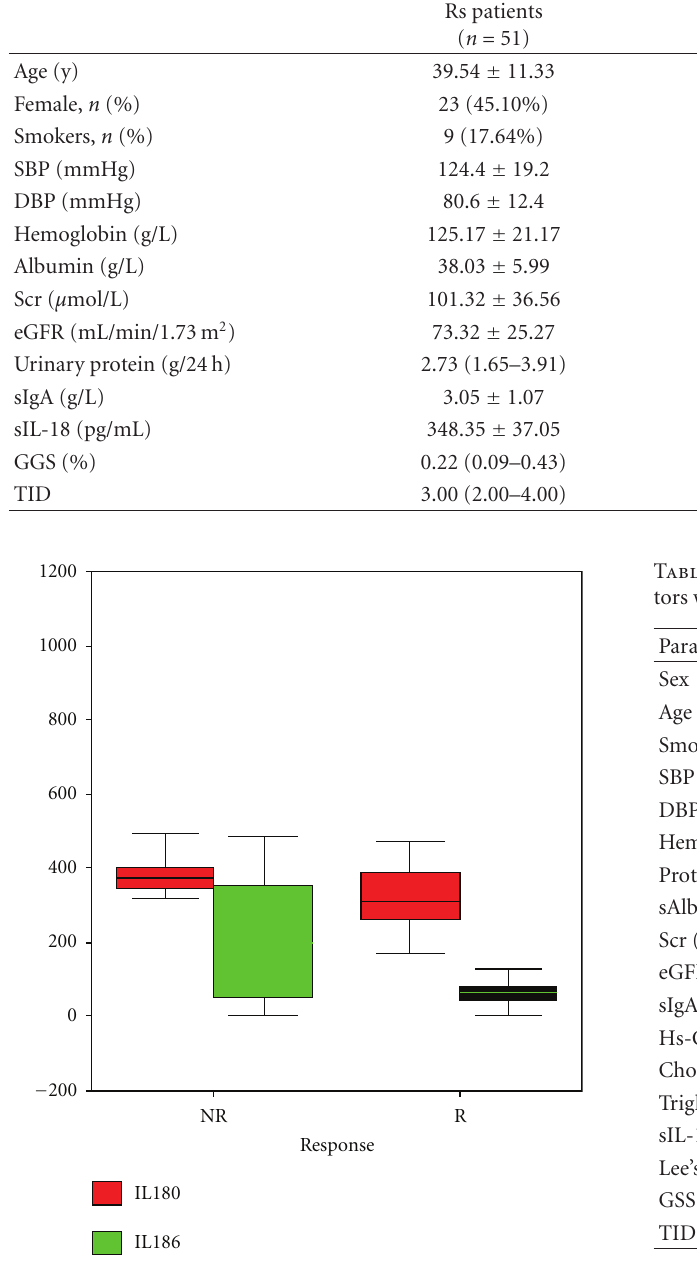
Figure 2: In patients respond to corticosteroid therapy (R group), sIL-18 decreased significantly both in responders and nonrespon- ders ( P < 0 . 05) while NRs patients showed much higher baseline IL-18 levels ( P = 0 . 02).